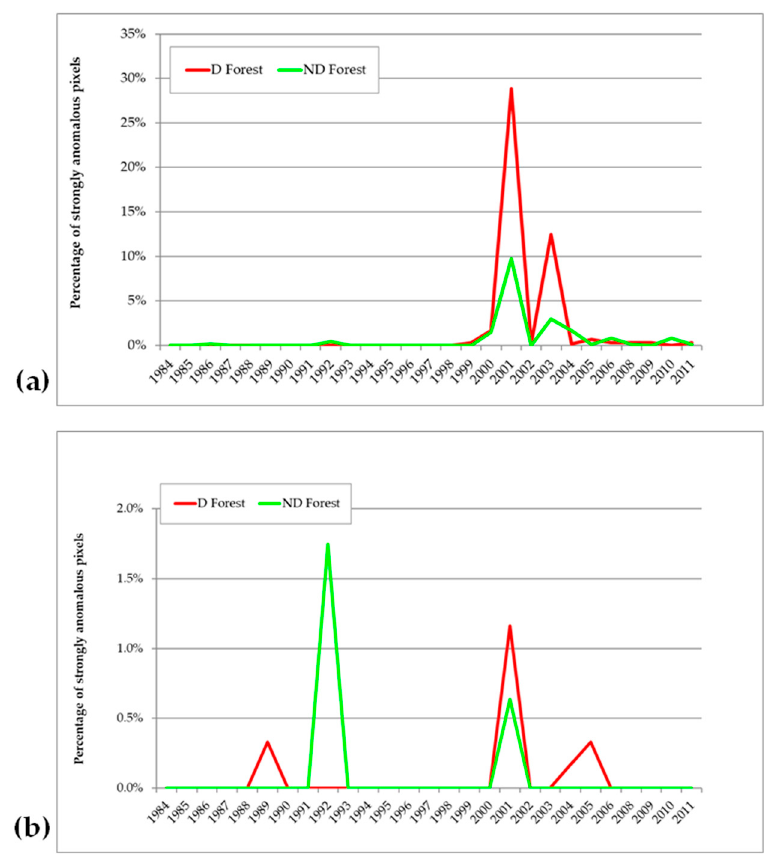
Figure 7. Percentage of pixels with strongly negative ALICE values ( ⨂ NDVI_MVC ( x , y , t ′ ) ≤ − 3) from 1984 to 2011 ( a ) in the Gorgoglione D (red line) and Accettura-Pietrapertosa ND (green line) forests; ( b ) in the D (red line) and ND (green line) forests of San Paolo Albanese.